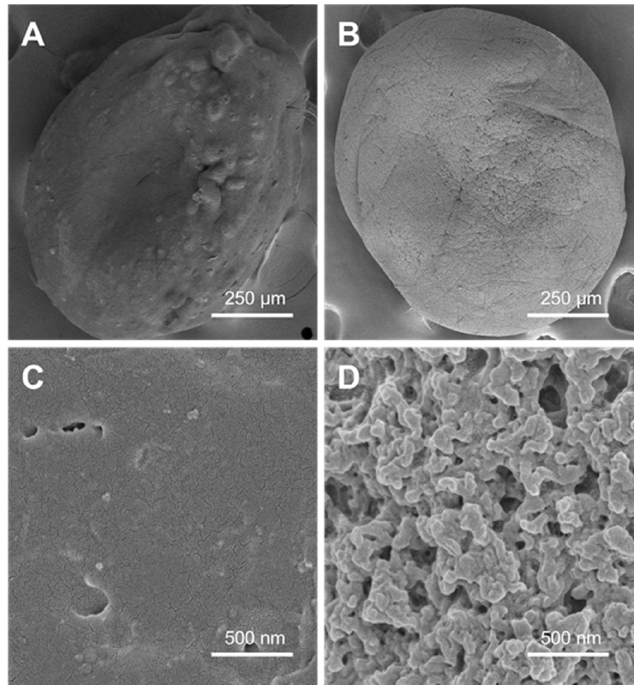
Figure 4. SEM images of ( A ) an oven dried chitosan bead, ( B ) oven dried nano-on-bead composite (200B-90m), ( C ) oven dried chitosan bead showing surface detail, and ( D ) oven dried nano-on-bead composite (200B-90m) showing surface